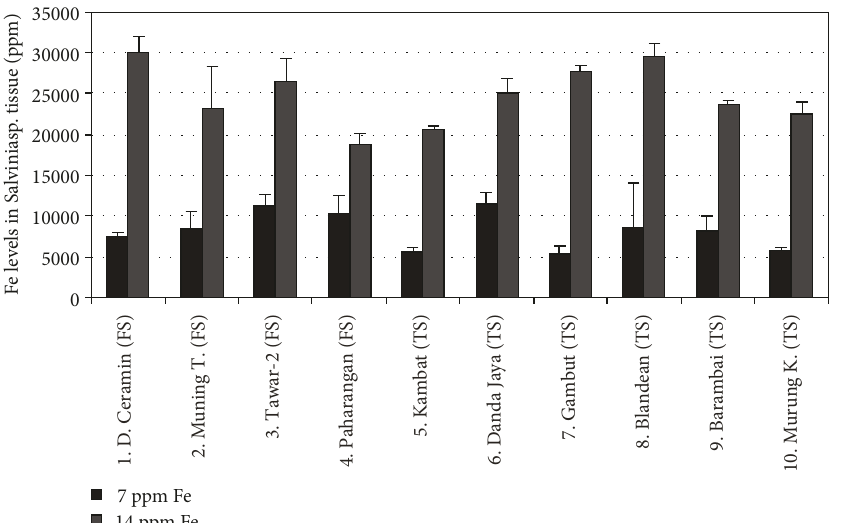
Figure 3: Fe levels in Salvinia sp. tissue that was cultured within 4 weeks in Hoagland nutrient solution enriched with 7ppm Fe and 14ppm Table 5: Biomass; doubling time; and the content of carbon, nitrogen, phosphor, potassium, and iron in Salvinia sp. tissue in nutrient solution after enriched with 7ppm Fe. Salvinia sp. accession